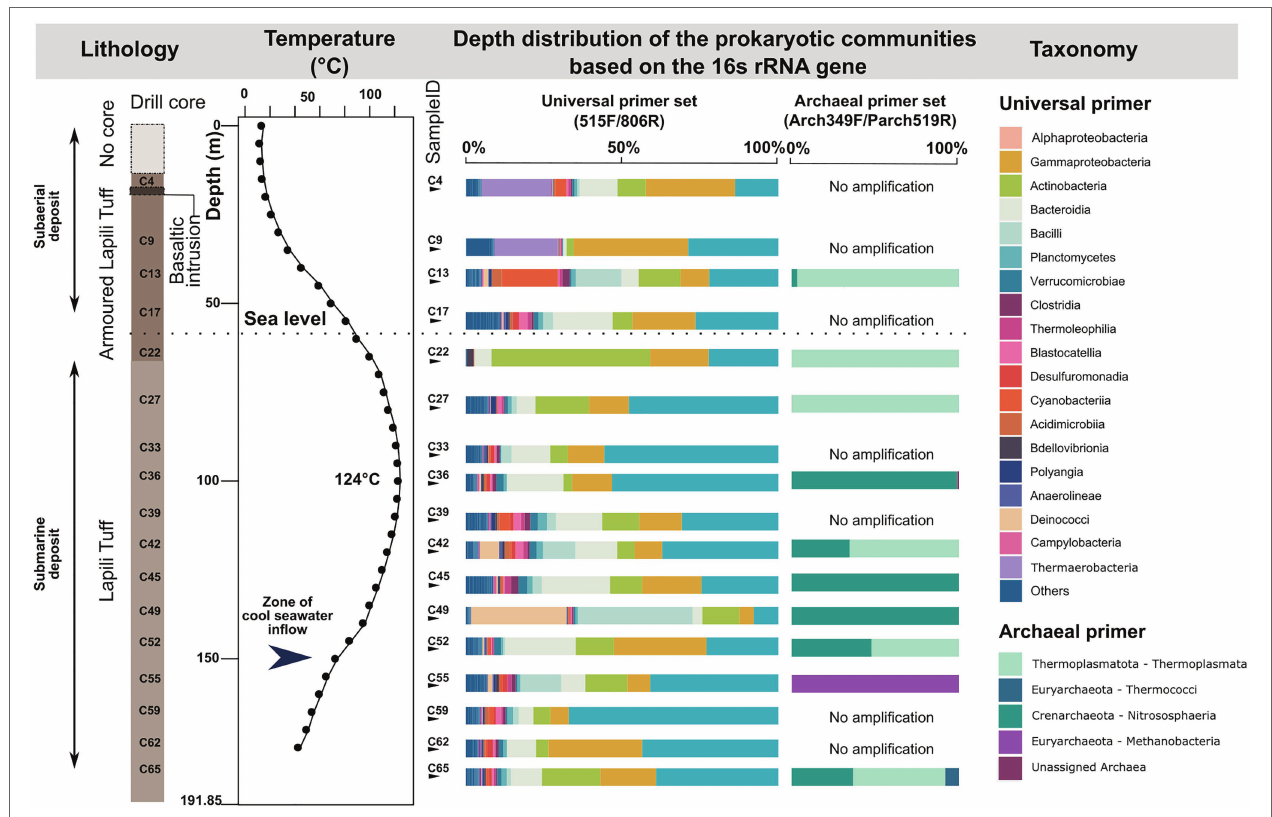
FIGURE 4 | Vertical distribution of the microbial communities at the phylum or class level detected in the 17 drill core samples from the subsurface of the Surtsey volcano using universal primer set and archaeal primer